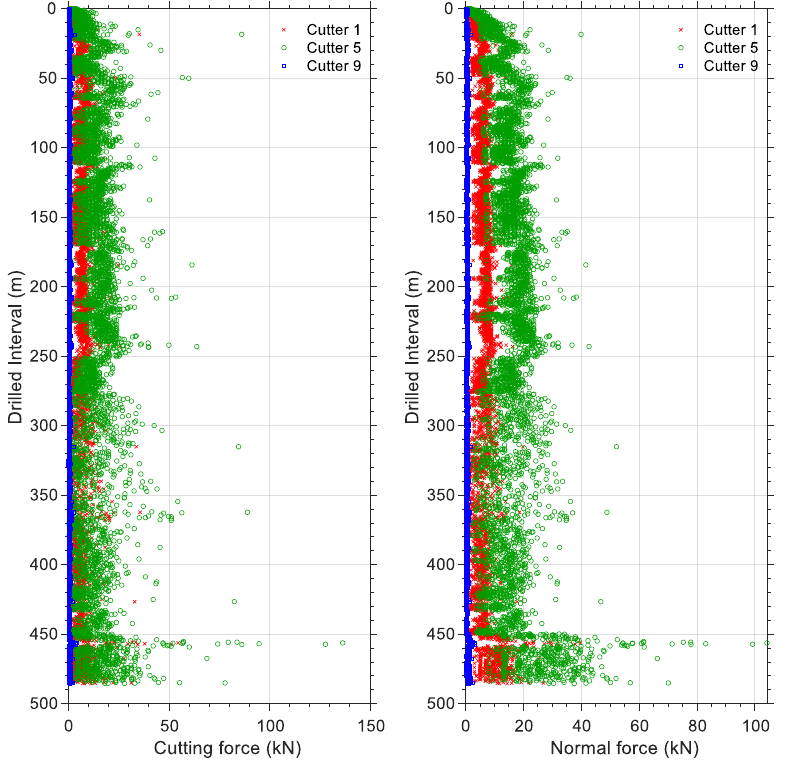
Figure 15. Specific energy ( left ) and torque ( right ) plots for bit run number 1 for three equivalent cutters; i.e., 1, 5, and